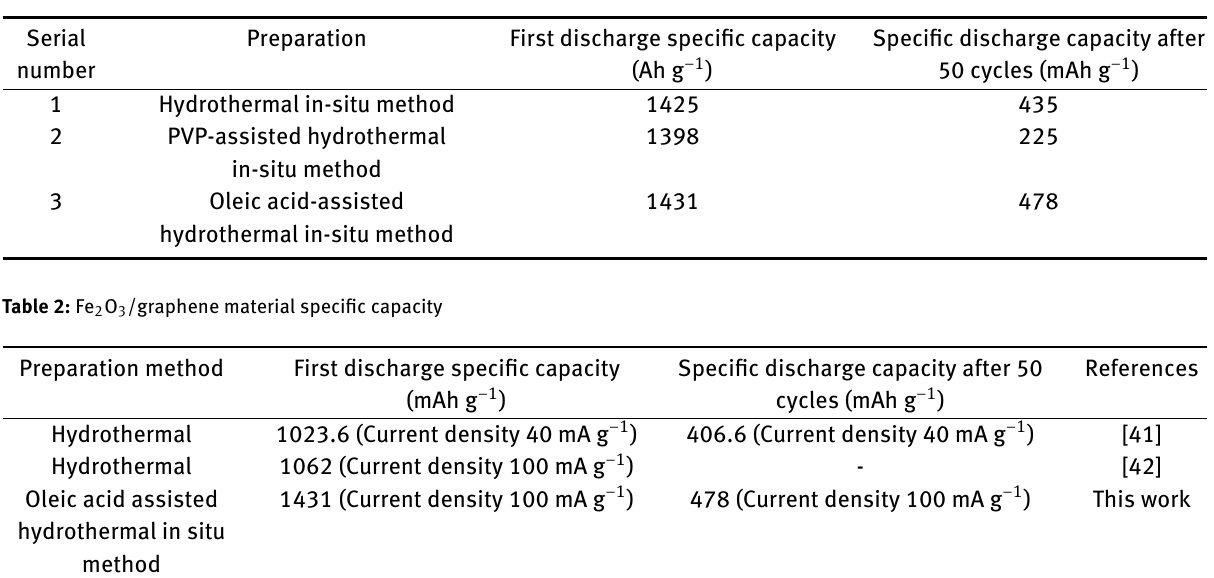
Table 1: Comparison of cycle stability of Fe 2 O 3 /rGO anode materials prepared by three hydrothermal processes